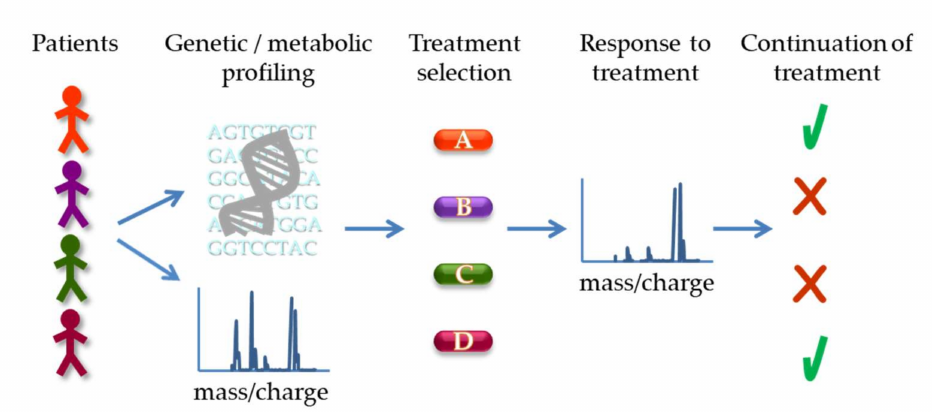
Figure 5. Potential application of genetic and metabolic profiling for treatment decision and response assessment. Patient samples can be subject to genetic sequencing to identify specific mutations as well as metabolomics analysis, e.g., by mass spectrometry, to profile metabolites (based on their mass/charge ratio schematically depicted). The results can guide the selection of the optimal treatment for the patient. Subsequently, metabolic analysis can also be used to assess response to therapy (illustrated as a shift in peaks in the spectrum) and determine continuation of the specific treatment or switch to a different